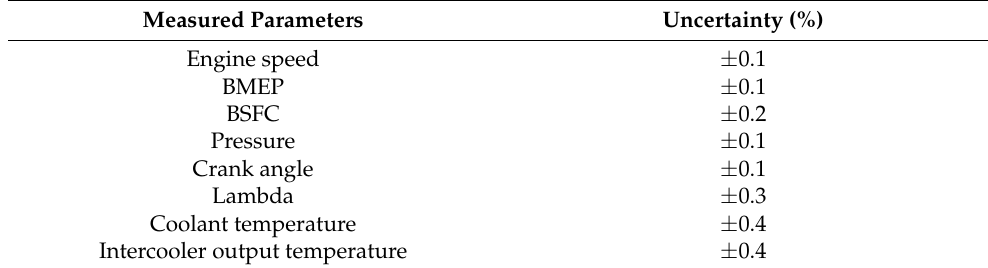
Table 4. Uncertainties of measured